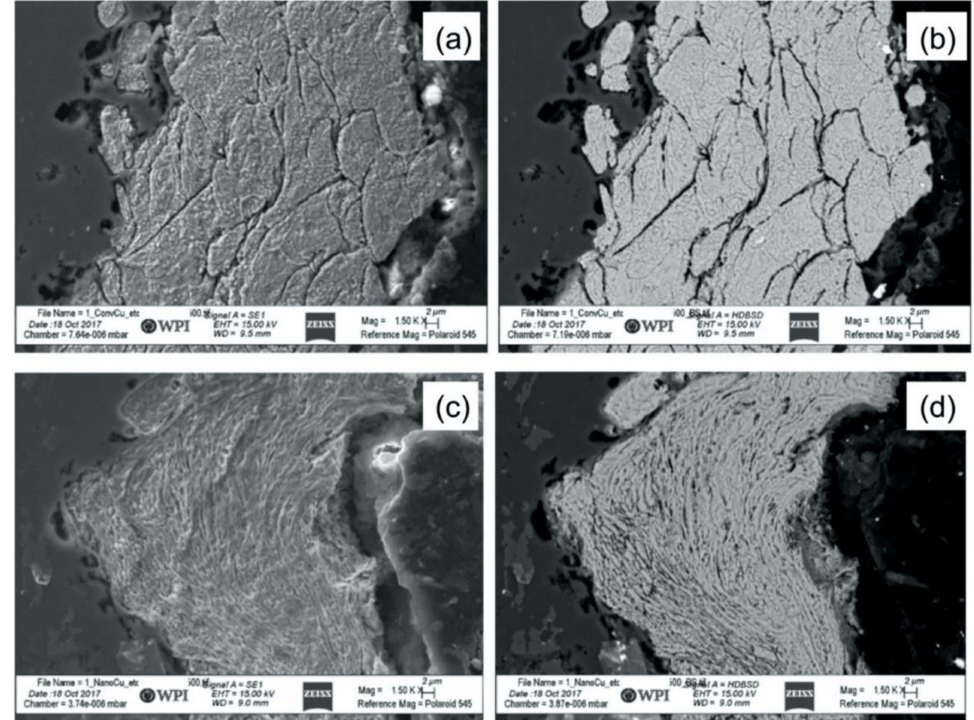
Figure 13. SEM micrographs of cross-sectioned and etched consolidated conventional Cu ( a ) and ( b ) as well as nanostructured cold sprayed Cu ( c ) and ( d